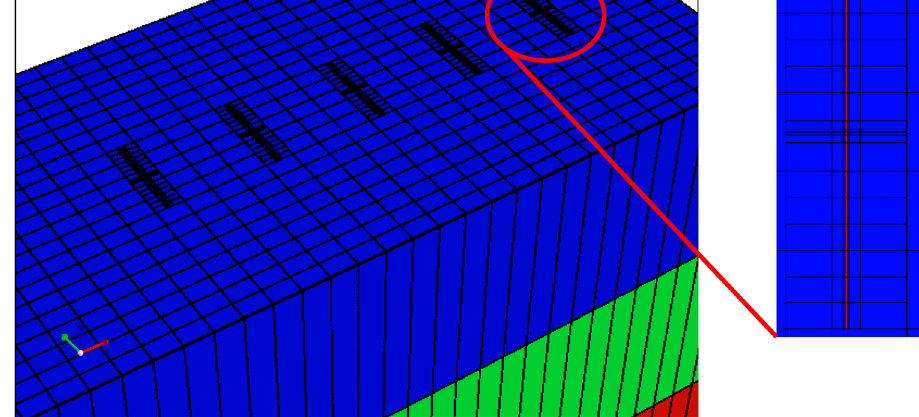
Fig. 7 Example of refined grid blocks of planar hydraulic frac- turing design